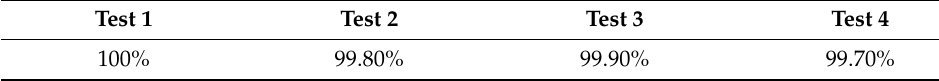
Table 2. Efficiency 1 : Results from four tests for the graph model.